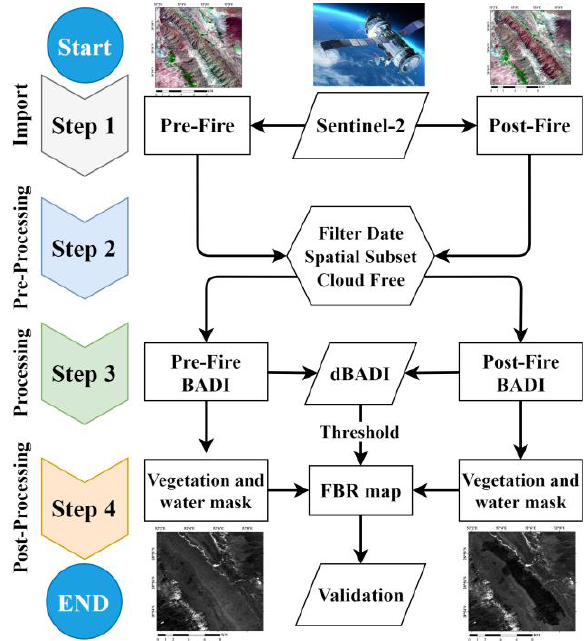
Figure 4. Flowchart of the novel BADI index for burned area detection.